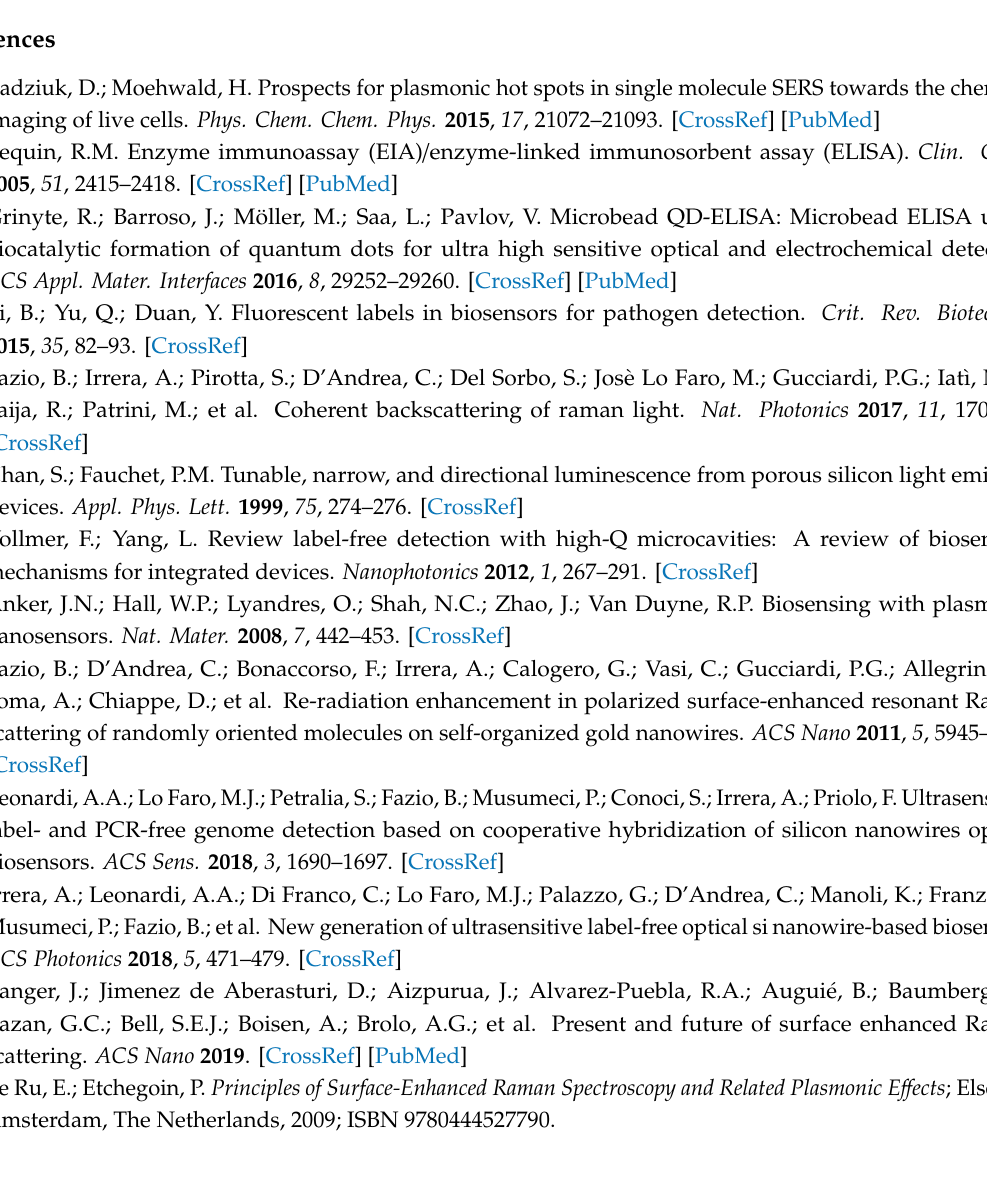
Figure S1: Contaminations study by Raman investigation of Ag dentrites; Figure S2: SERS and Raman detection of Lyz in the aromatic residues ring breathing modes spectral region; Figure S3: Raman spectrum of liquid